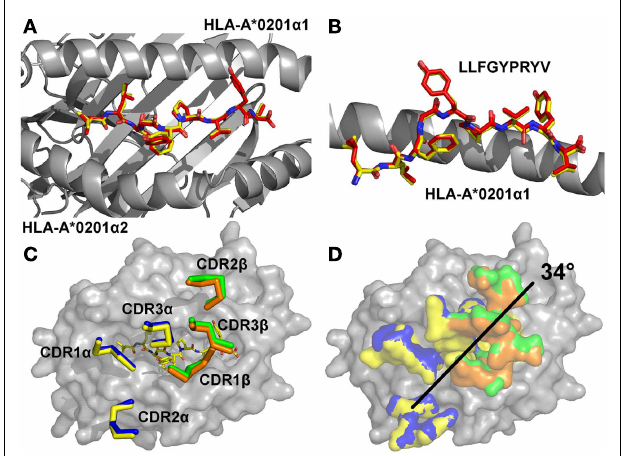
FIGURE 1 |The overall conformations ofA6wt andA6c134TCRs in complex withA2-Tax are similar . (A) Comparison of peptide conformation in the A6wtTCR (red sticks) and A6c134TCR (yellow sticks) complex structures looking down on top of the MHC groove (gray sticks). (B) Comparison of peptide conformation in the A6wtTCR (red sticks) and A6c134TCR (yellow sticks) complex structures looking from the side of the MHC groove (gray sticks). (C) Comparison of CDR loop conformation in the A6wtTCR (yellow and orange ribbons) and A6c134TCR (blue and green ribbon) A2-Tax complex structures. (D) Crossing angle comparison of the A6wtTCR and A6c134TCR in complex with A2-Tax. Colors as in C.